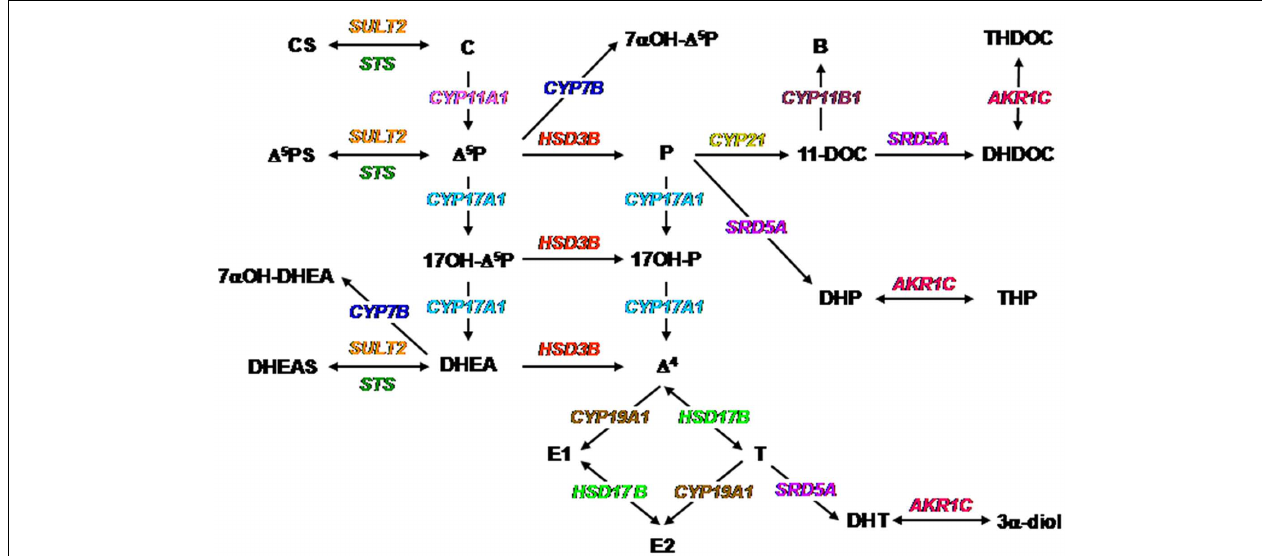
FIGURE 1 | Biochemical pathways for the synthesis of neurosteroids. The color code is the same as that used in Figures 2 – 6 . Abbreviations for steroids: B, corticosterone; C, cholesterol; CS, cholesterol sulfate; Δ 4 , androstenedione; Δ 5 P, pregnenolone; Δ 5 PS, pregnenolone sulfate; DHEA, dehydroepiandrosterone; DHEAS, dehydroepiandrosterone sulfate; DHDOC, dihydrodeoxycorticosterone; DHP, dihydroprogesterone; DHT, dihydrotestosterone; E1, estrone; E2, estradiol; P, progesterone;T, testosterone;THDOC, tetrahydrodeoxycorticosterone;THP, tetrahydroprogesterone; 3 α -diol, androstanediol; 7 α -OH- Δ 5 P, 7 α -hydroxypregnenolone; 7 α -OH-DHEA, 7 α